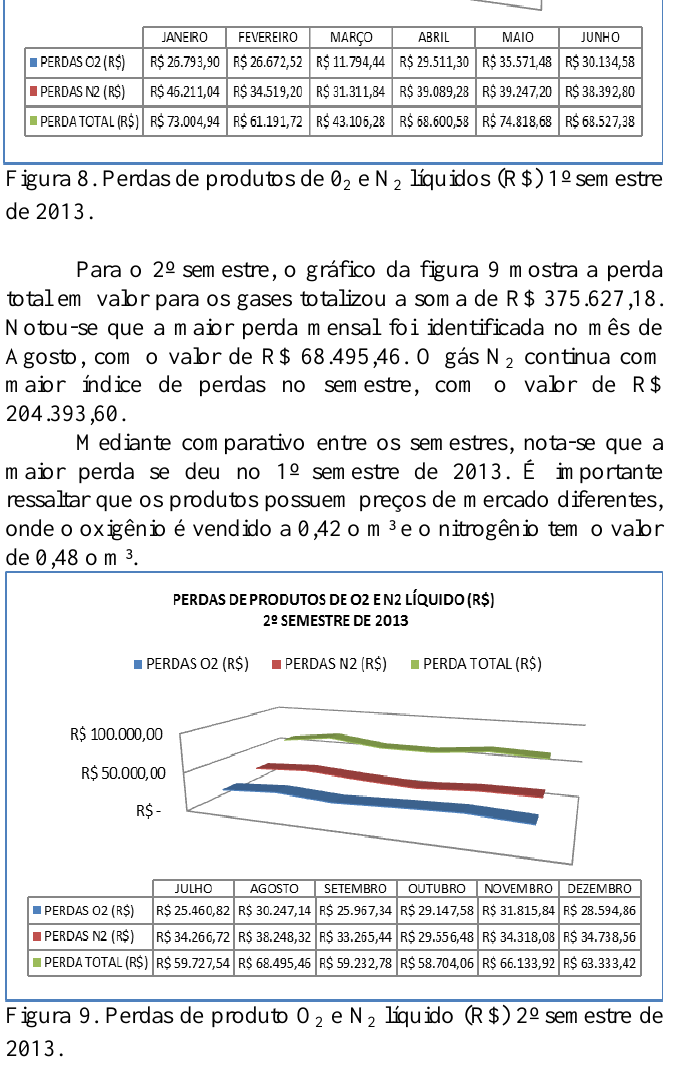
e N líquido (R$) 2º semestre de 2 2